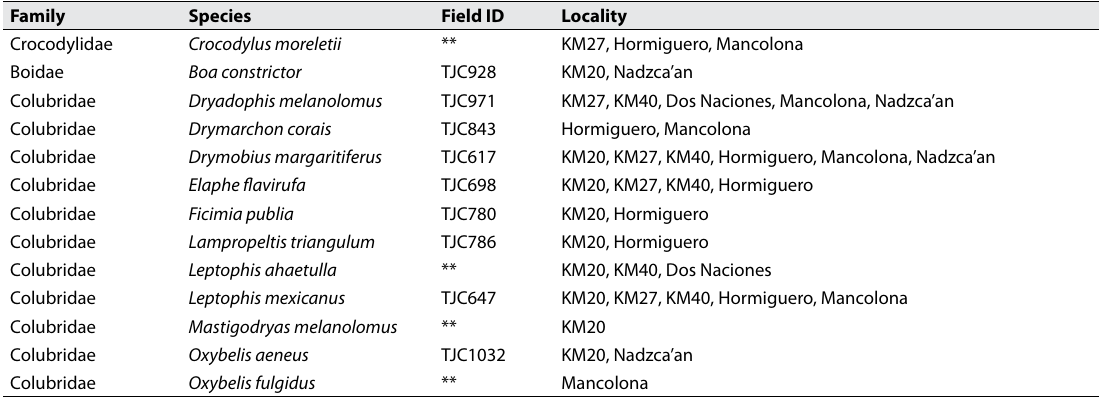
Table 2. List of reptiles encountered and localities in the CBR. *New records not previously reported for the area.